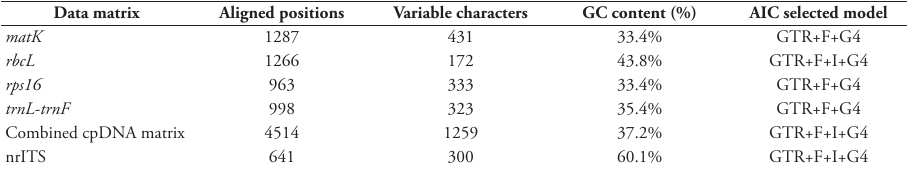
Table 1. Properties and best-fitting models of data partitions used in this study. Data